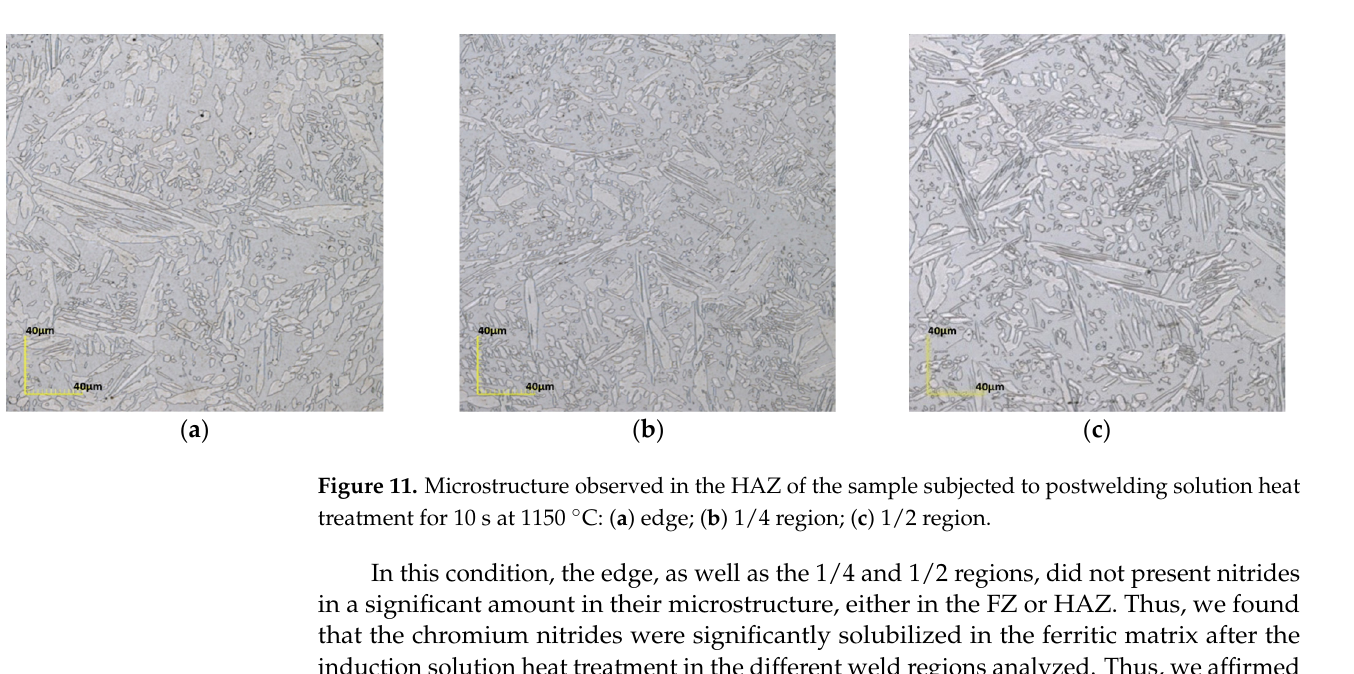
Figure 10. Microstructure observed in the FZ of the sample subjected to postwelding solution heat treatment for 10 s at 1150 °C: ( a ) edge; ( b ) 1/4 region; ( c ) 1/2 region.